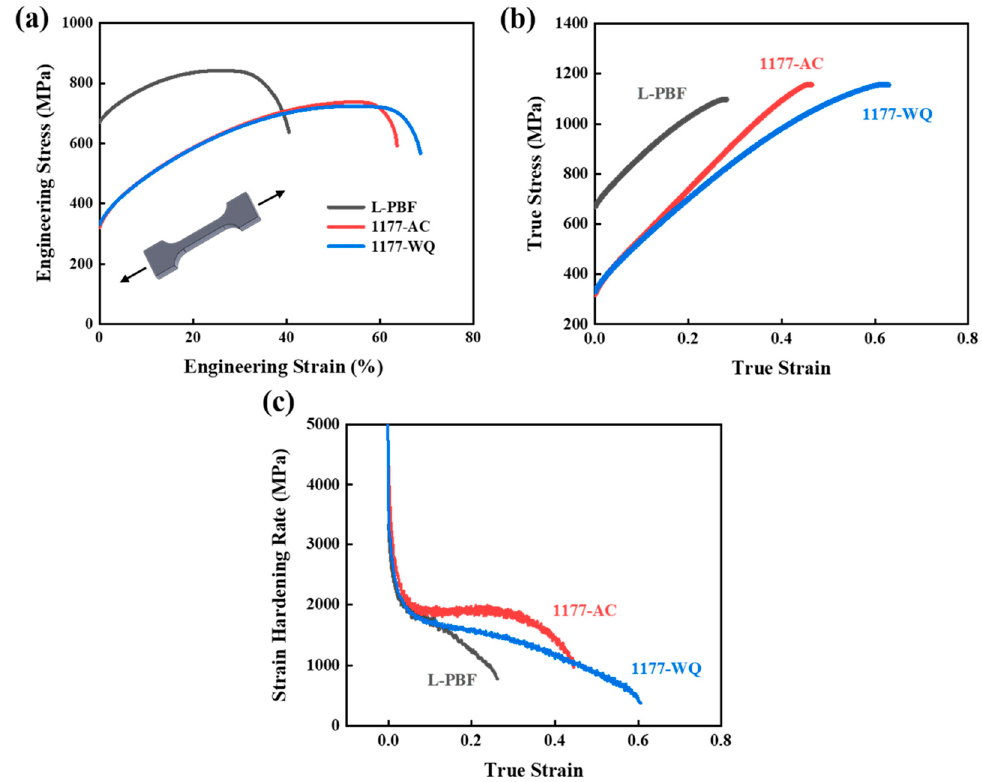
Figure 4. Mechanical properties of the L-PBFed and HTed samples. ( a , b ) Engineering and true stress–strain curves of different samples. ( c ) Strain-hardening rate of different samples.